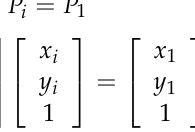
Figure 12. All the edge points are converted to the M-array coordinate system. Since the accuracy of M-array calibration directly affects the final result of the whole measurement system, this paper verifies the accuracy of the calibration method. Because the object to be measured and the M-array are always in the same plane, the dimension calculation of the object to be measured depends on the corner extraction of the M-array and the accuracy of the coordinate system transformation. The accumulated manufactur- ing error of the photo-etching glass board that can cover the field of five cameras is within 0.25 um, so we believe that all the corner points in the same row or column lie on a phys- ical straight line. Due to the existence of errors from the corner point extraction algorithm and errors caused by distortion, extracted corner points deviate from the linear discrete distribution. For the M-array images captured by five cameras, a random row of corner points is extracted, respectively, and the distribution in the image coordinate system is shown as the black line in Figure 13. Through the coordinate system transformation established by our method, it corresponds to the M-array coordinate system, as shown in the red line in Figure 13. Figure 13a–e correspond to cameras C1–C5 respectively. Due to the existence of corner point extraction and distortion error, the corner point distribution fluctuates in the range of straight line ±0.2 pixels. It is mapped to the decoded physical coordinate sys- tem to remove the distortion, and then converted to the same ordinate pixel unit. The corner points fluctuate in the range of ±0.1 pixels, that is ±0.2 um. Since the corner point is calculated based on minimum classification error, so there are still subtle fluctuations in the M-array coordinate system.